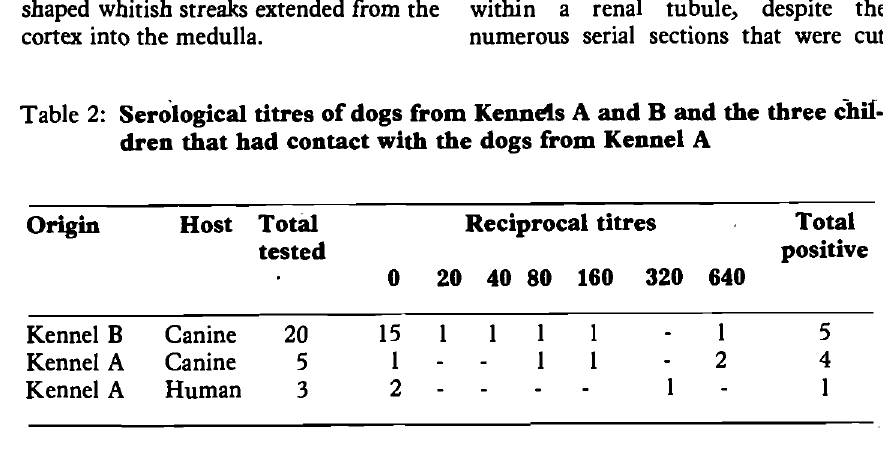
Table 2: Serological titres of dogs &om Kennels A and B and the three chilo